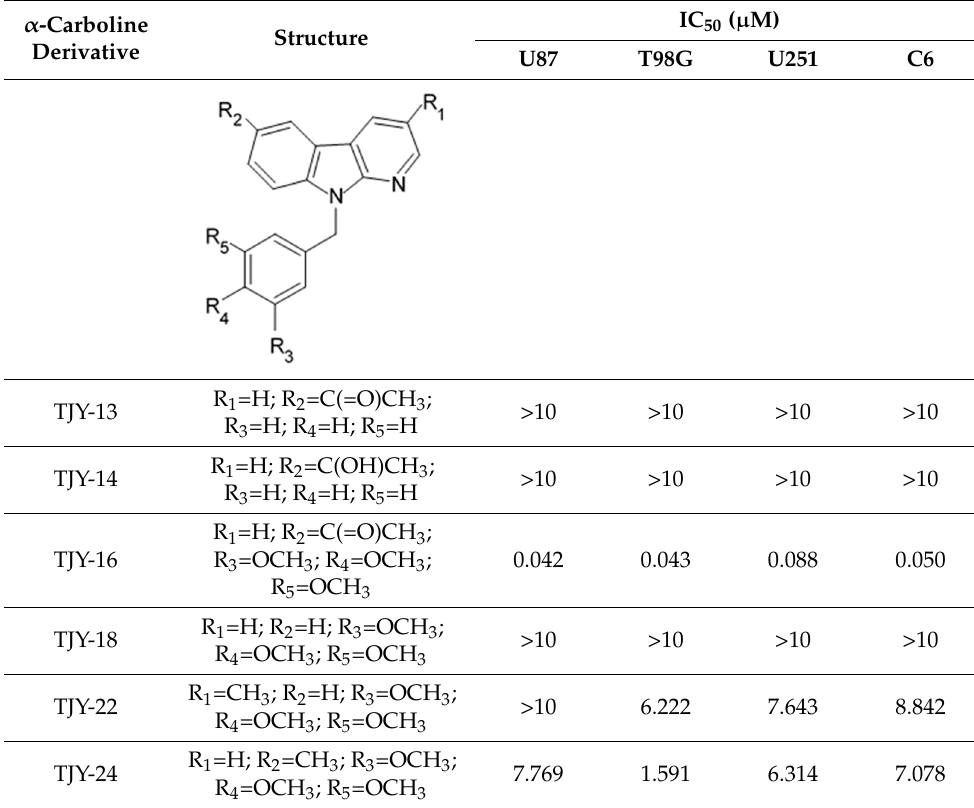
Table 4. Anti-glioma activities of α -carboline derivatives against glioma cells in vitro [69]. α -Carboline Structure α -Carboline Derivative